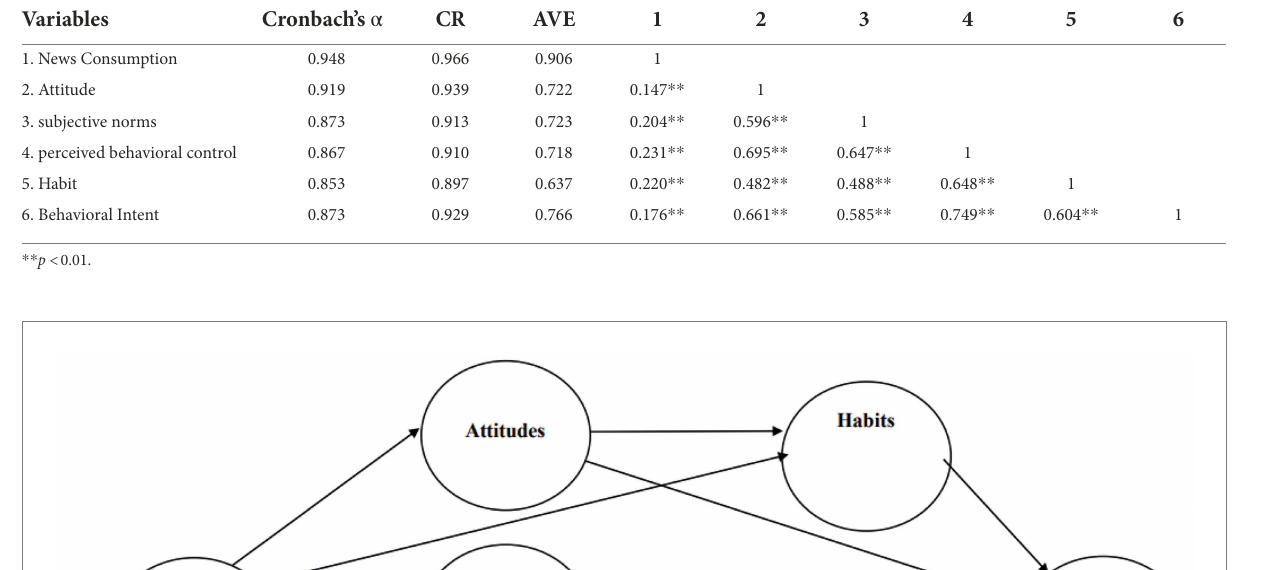
TABLE 1 The reliability, validity, and correlation of